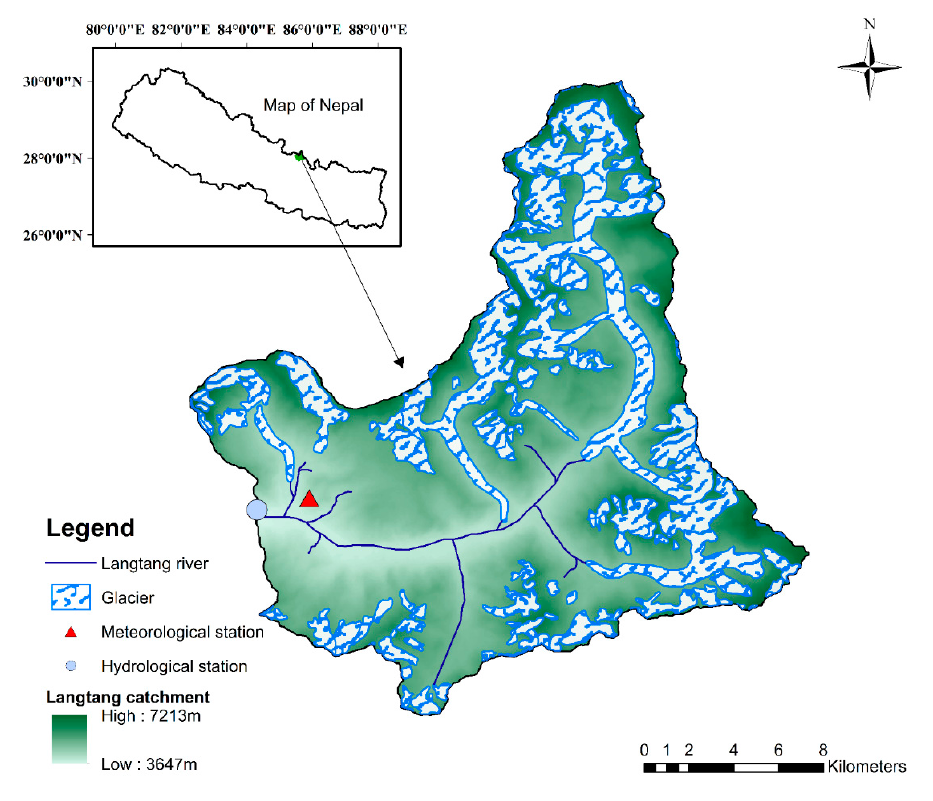
Figure 1. Map of the study area.